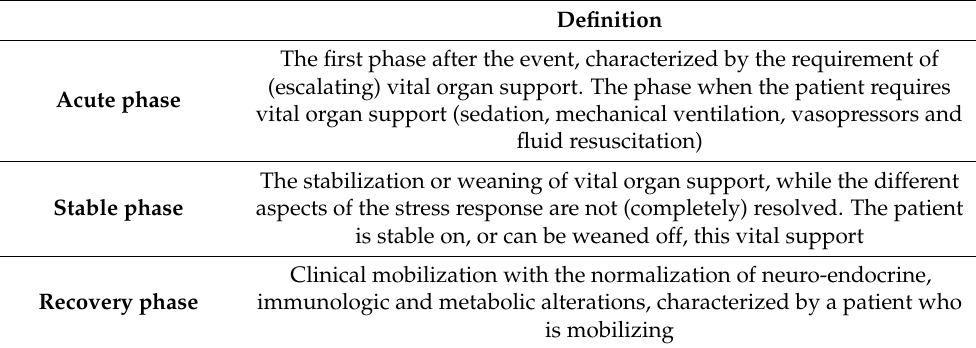
Table 1. The definitions of the three phases of the stress response in critically ill children (Ref.